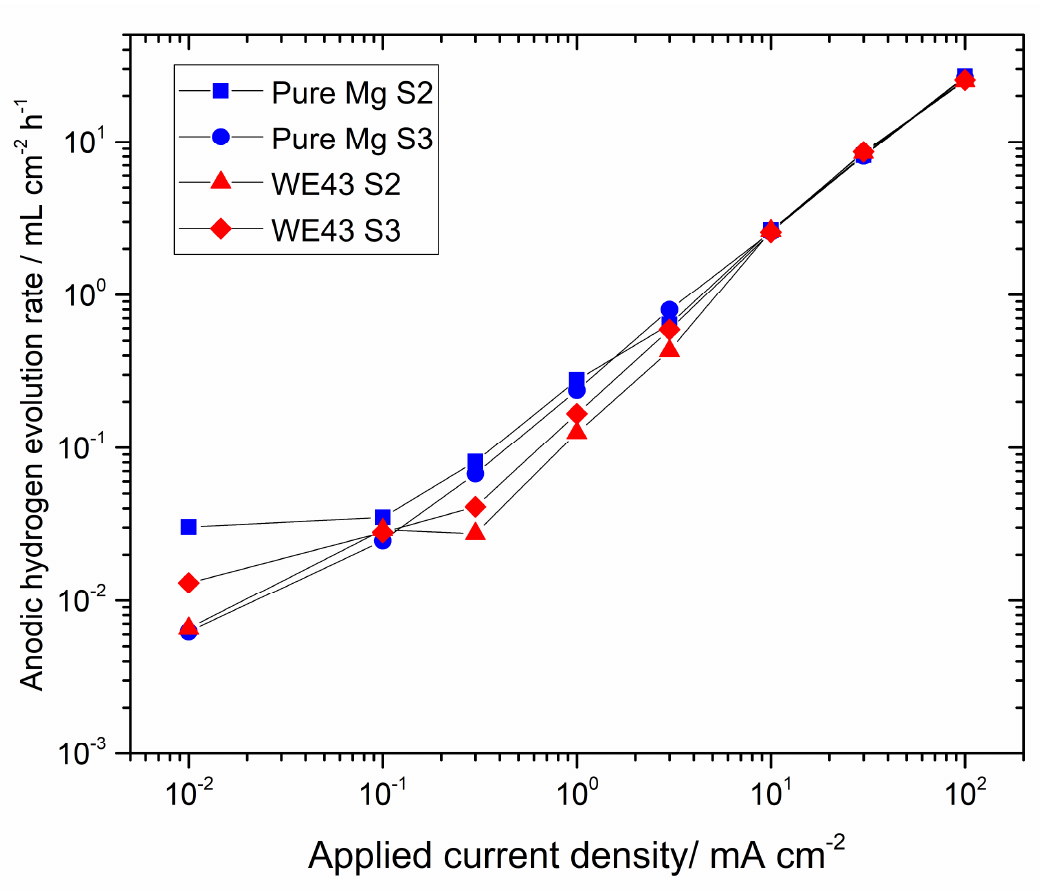
Figure 10. The anodic hydrogen evolution rate for various values of applied current density for pure Mg and the Mg alloy WE43 [92].